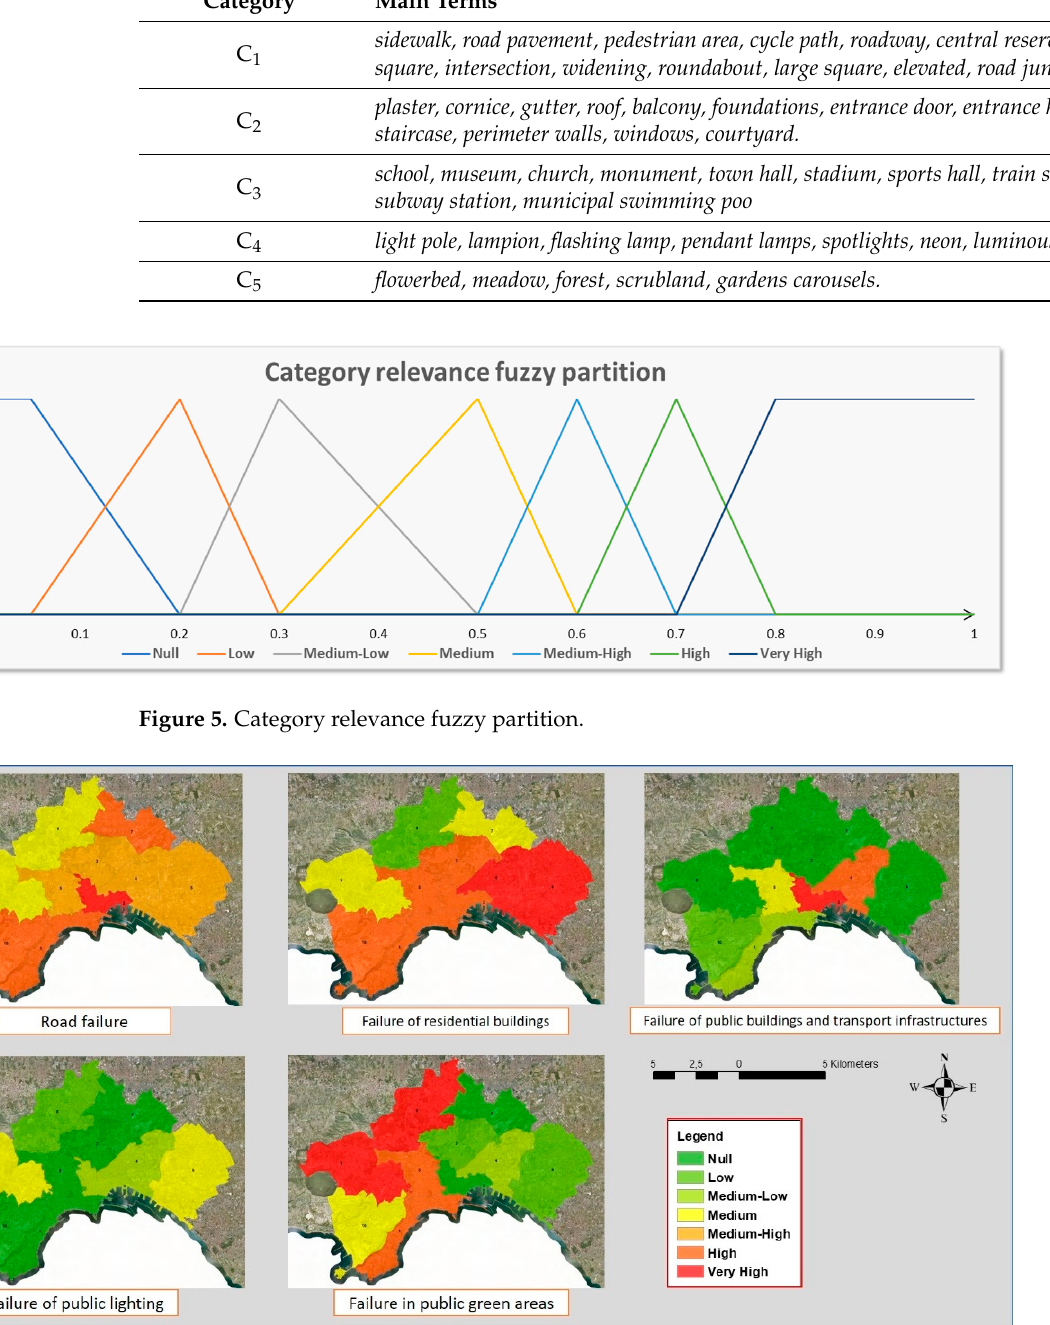
Figure 6. Category thematic maps obtained in the year 2020.